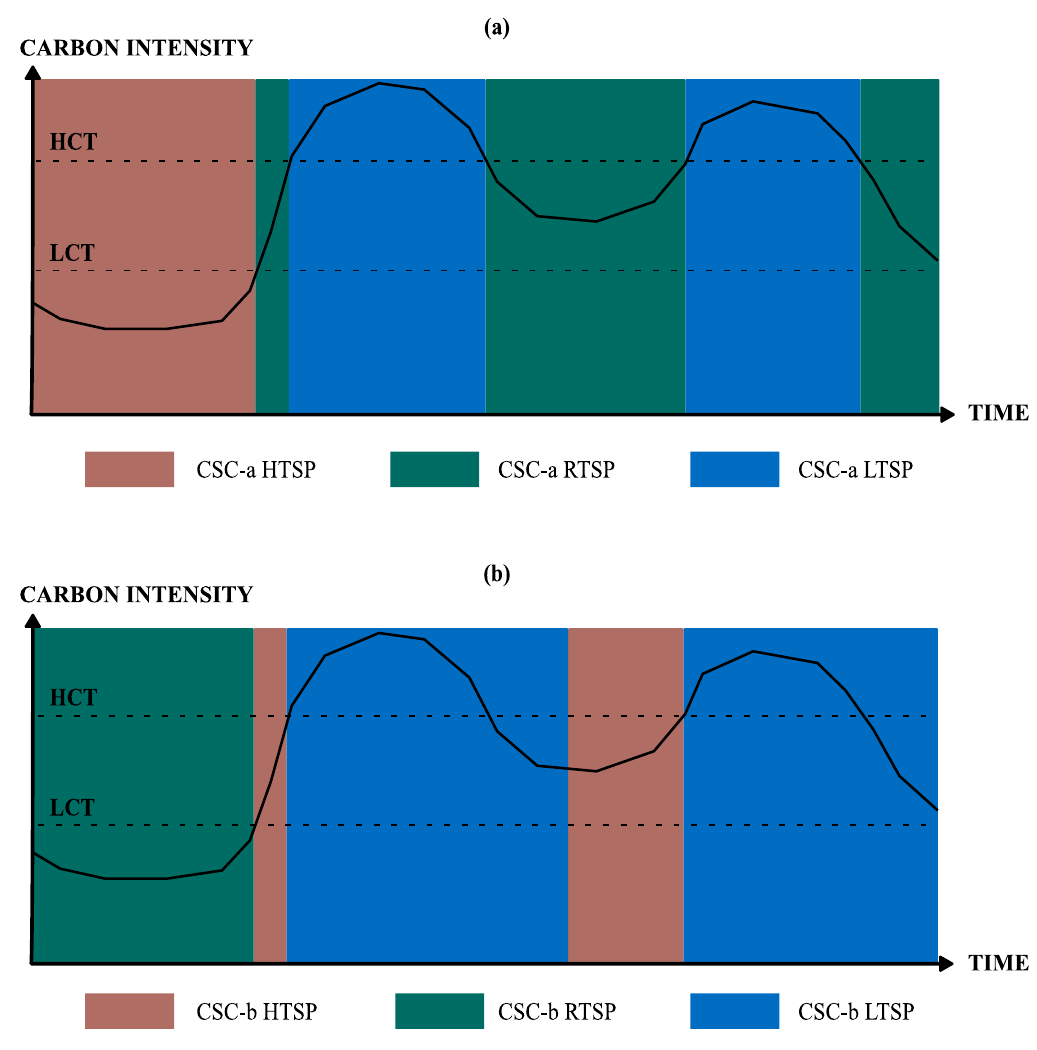
Figure 5. Principle of the determination of the carbon-based control signal according to ( a ) CSC-a and ( b ) CSC-b. (HTSP is high temperature set-points, RTSP is reference temperature set-points, LTSP is low temperature set-points).